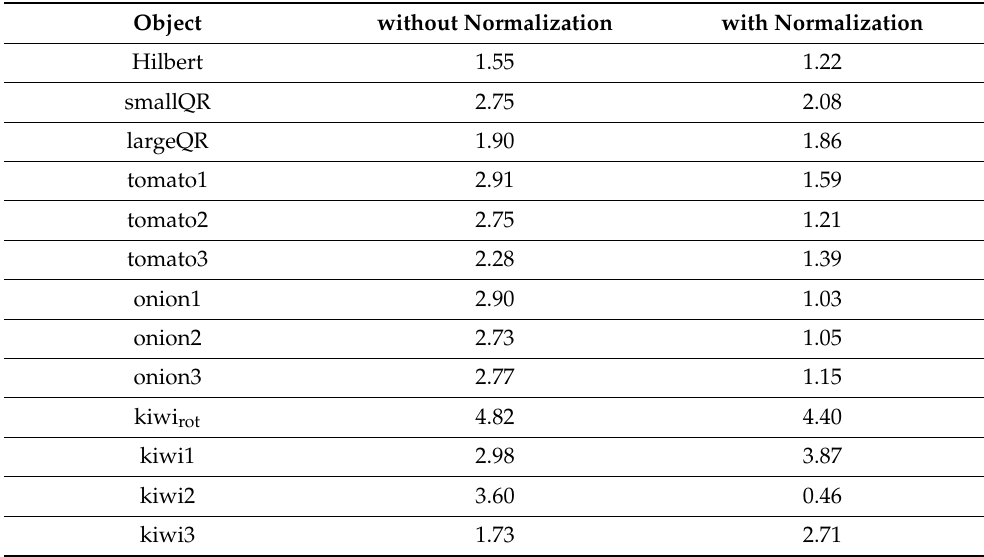
Table 4. Repeatability is expressed via CV average , in the case of normalized and non-normalized images. At normalized images, lower CV values can be observed in most cases. Object without Normalization with Normalization Hilbert